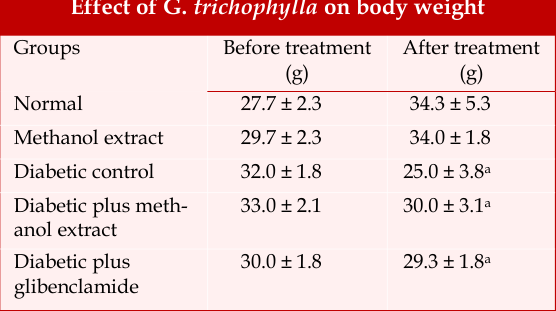
Effect of G. trichophylla on body